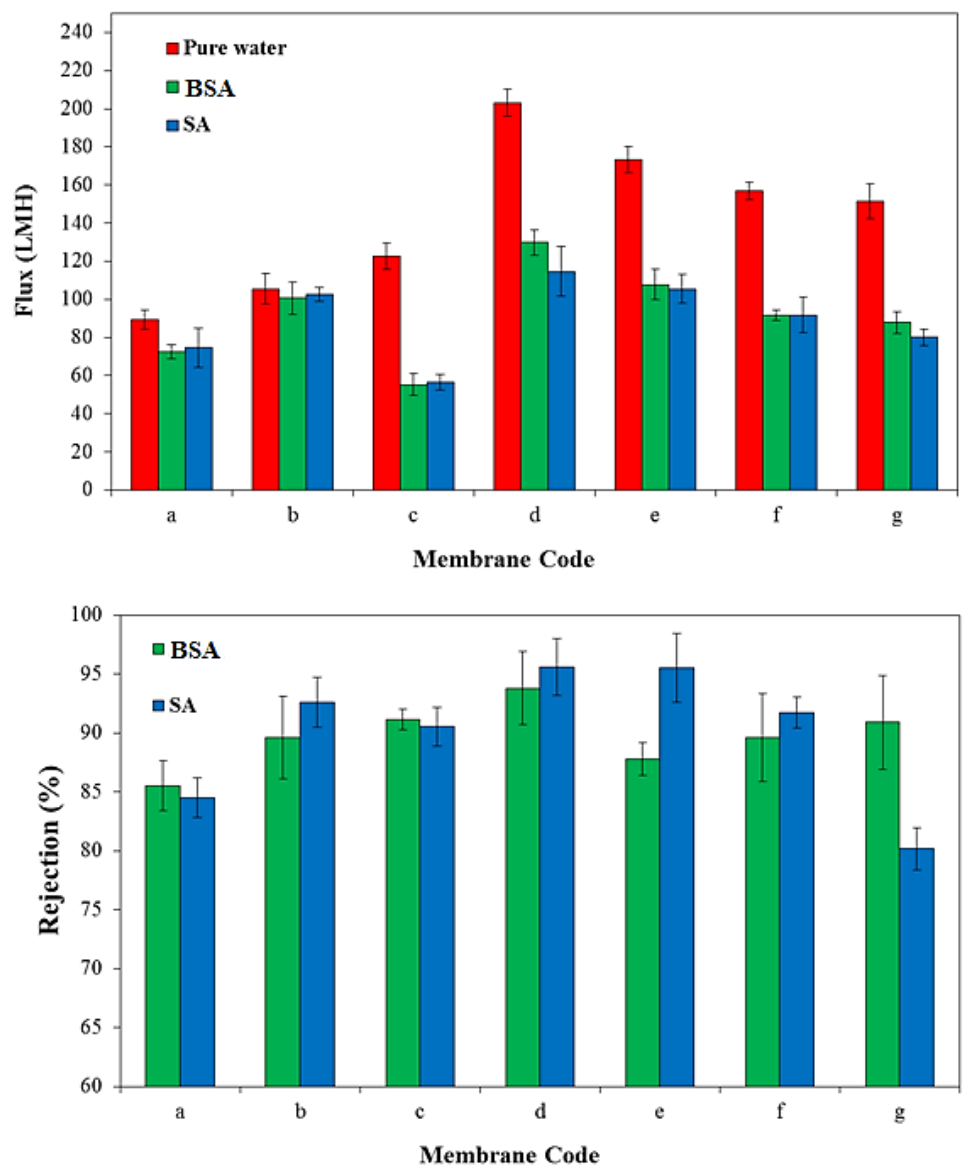
Figure 8. ( Top ) Pure water, BSA and SA flux; and ( Bottom ) BSA and SA rejection of ( a ) PES, ( b ) PES/PTGM (1 wt.%), ( c ) PES/PTGM (3 wt.%), ( d ) PES/PTGM (5 wt.%), ( e ) PES/PTGM (7 wt.%), ( f ) PES/PTGM (9 wt.%), and ( g ) PES/PTGM (11 wt.%).